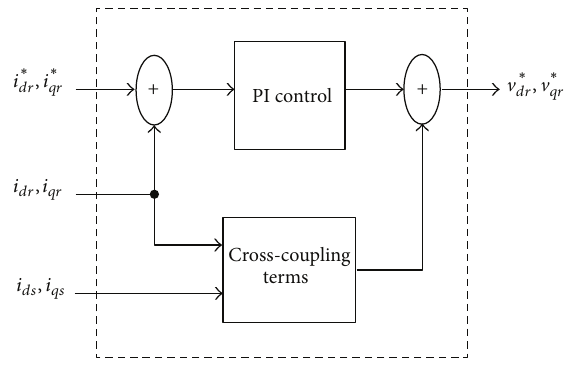
Figure 5: Conventional (indirect) current